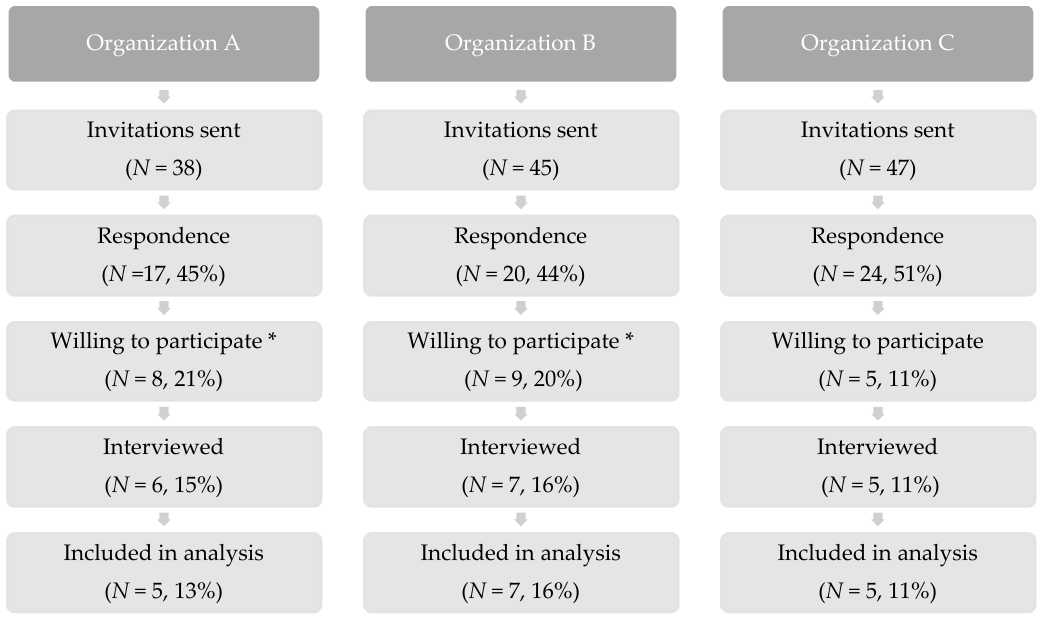
Figure 4. Flow diagram of recruitment. * inclusive participants that were not within the inclusion criteria or canceled.